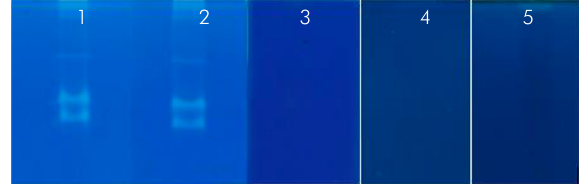
Figure 3. Effect of the different treatments tested in vitro on the MMPs from the dentin extract. Gelatinase zymography, in triplicate, of (1) no treatment, (2) 0.05% NaF, (3) 0.12% chlorhexidine digluconate, (4) green tea, and (5) 0.1% EGCG, respectively.